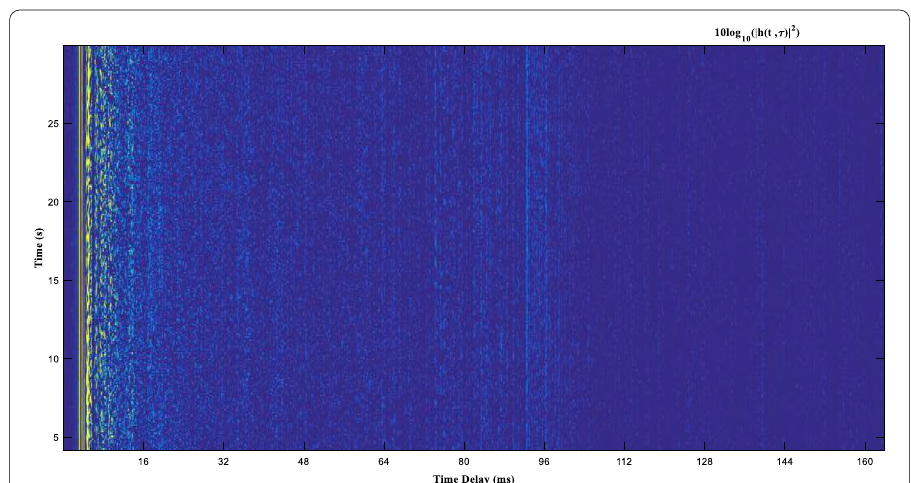
Fig. 15 Time-varying channel impulse response of a NOF1 watermark channel